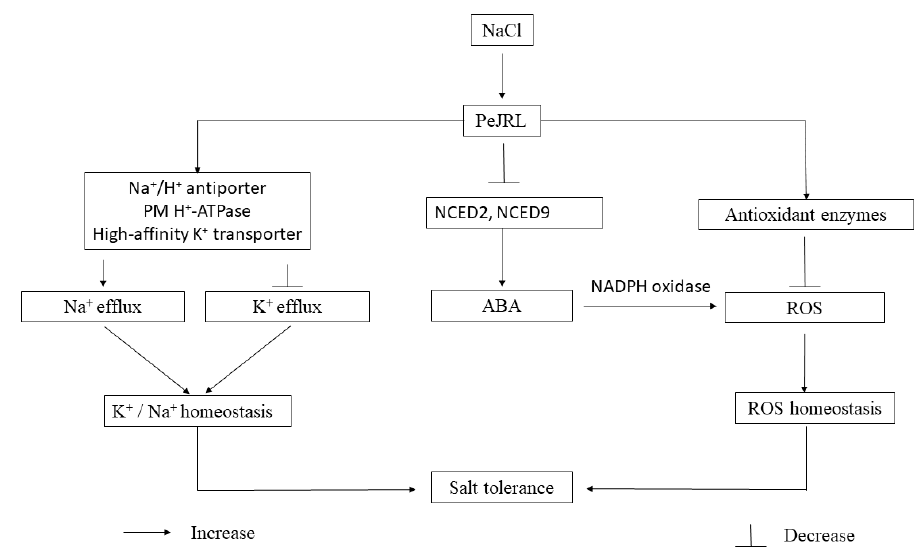
Figure 14. A schematic model showing mediation of Populus euphratica JRL in plant response to salt stress.